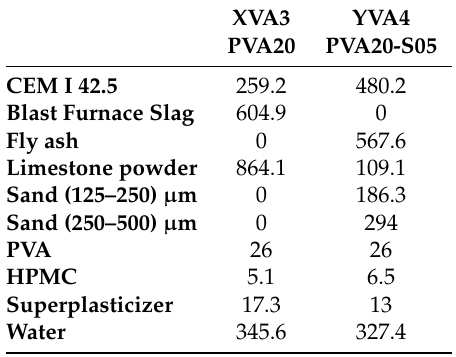
Table 1. Mix design summary in [kg/m 3 ].